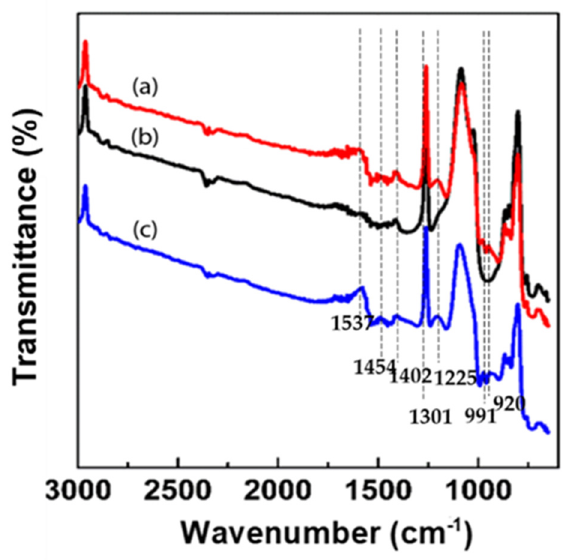
Figure 1. FT–IR spectra of ( a ) PPy/CNT– E. coli , ( b ) CNT, and ( c ) PPy/CNT. Figure 1. FT (cid:3398) IR spectra of ( a ) PPy/CNT– E. coli , ( b ) CNT, and ( c ) PPy/CNT.